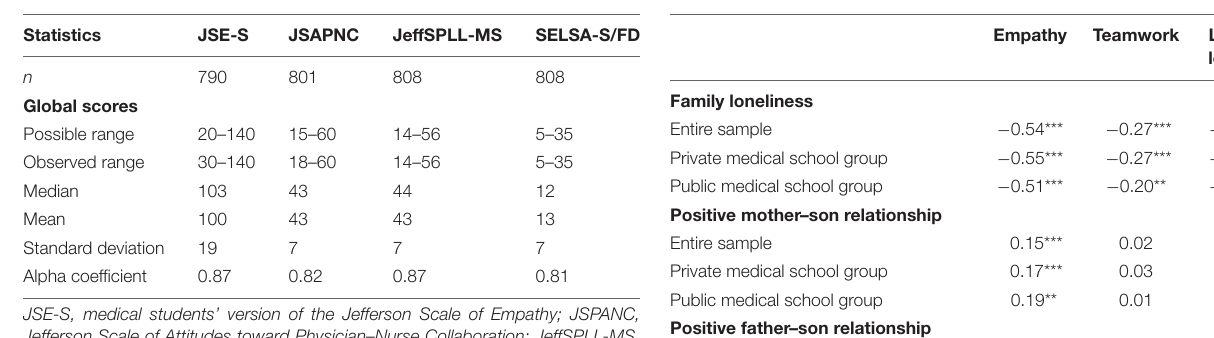
TABLE 2 | Spearman’s correlation coefficients for empathy, teamwork, and lifelong learning according to family environment